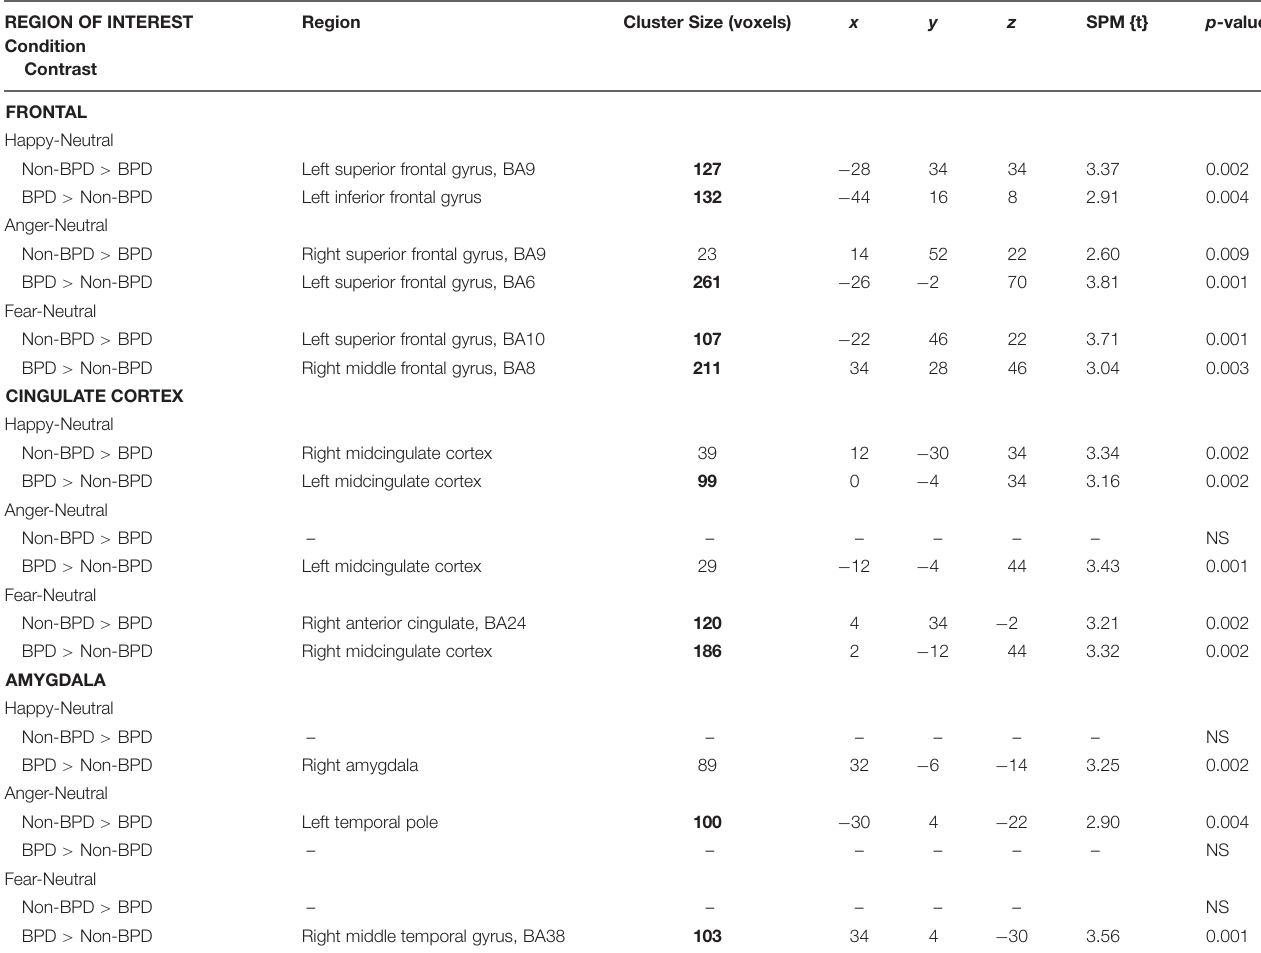
TABLE 2 | Masked affect fMRI results: contrast